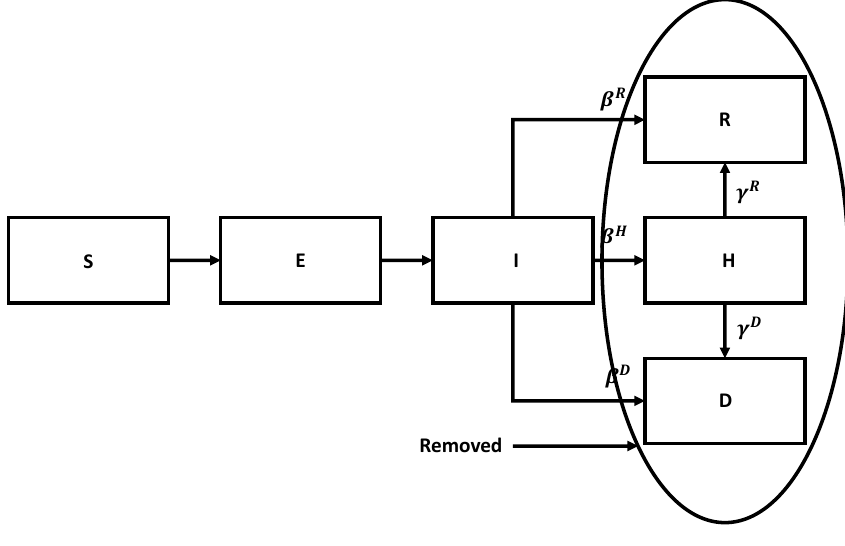
Figure 5. A simplified flowchart for the SIR